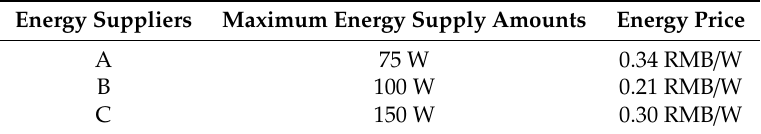
Figure 4. Energy purchase schemes of BSs under K = 200.